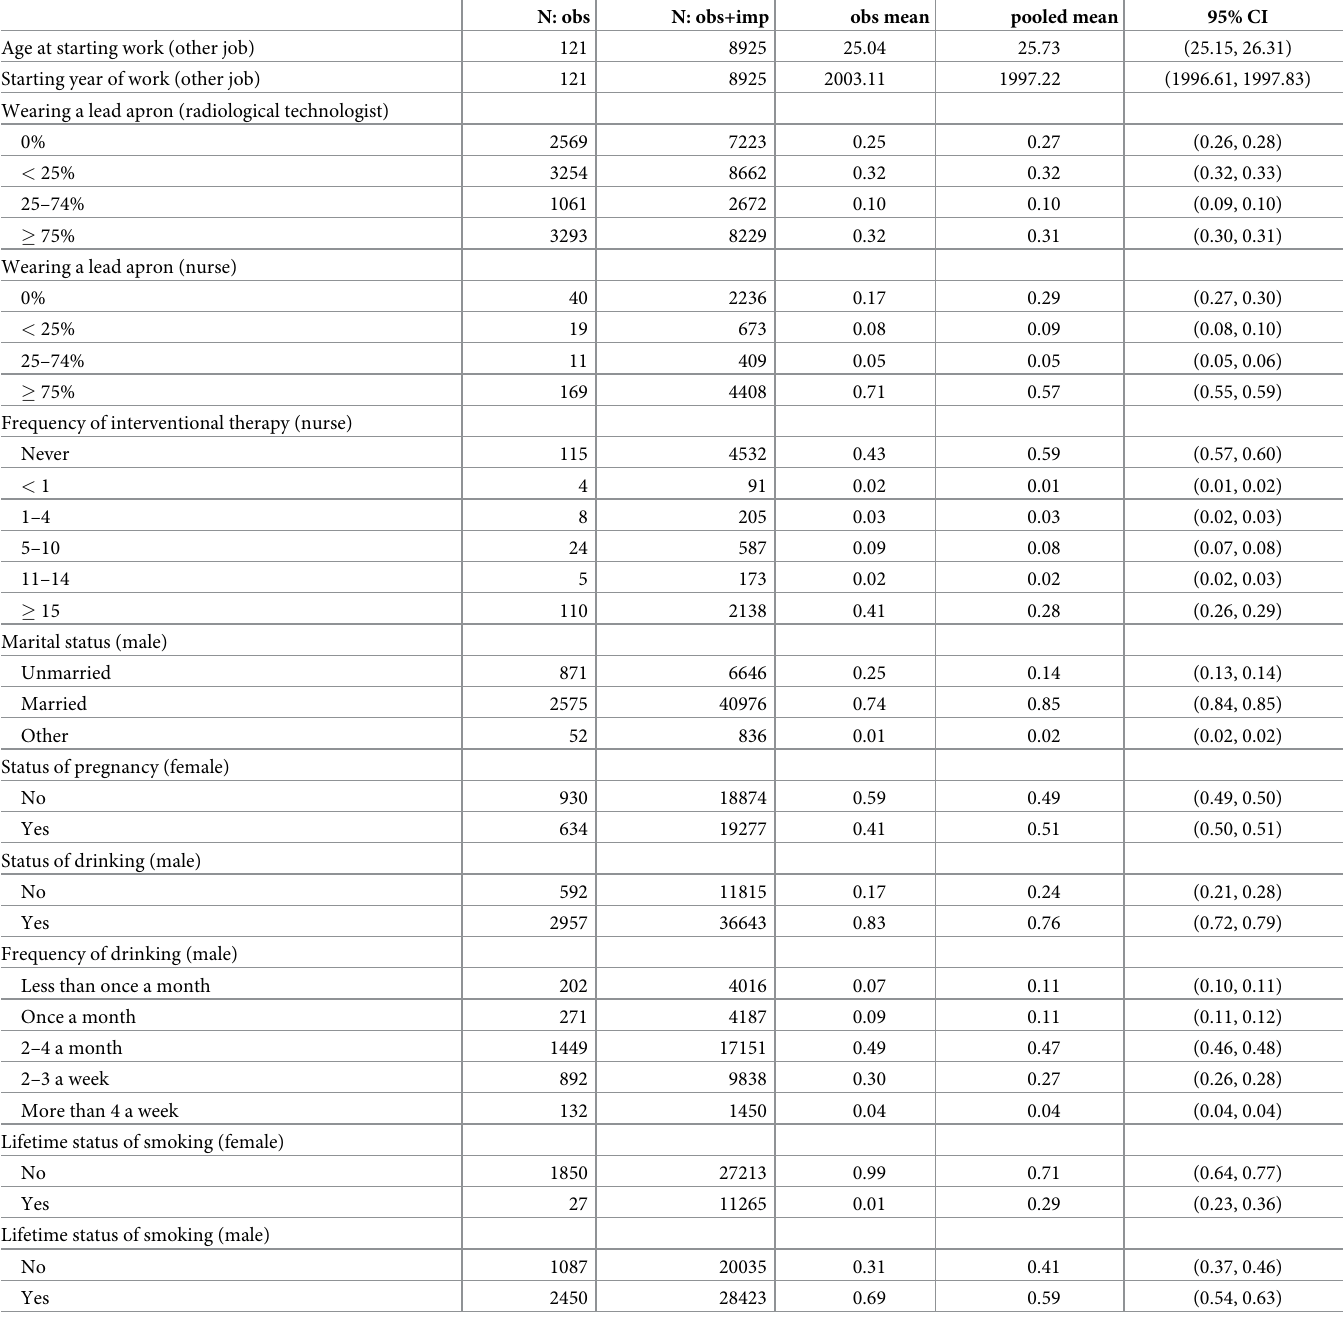
Table 2. Pooled mean and confidence interval